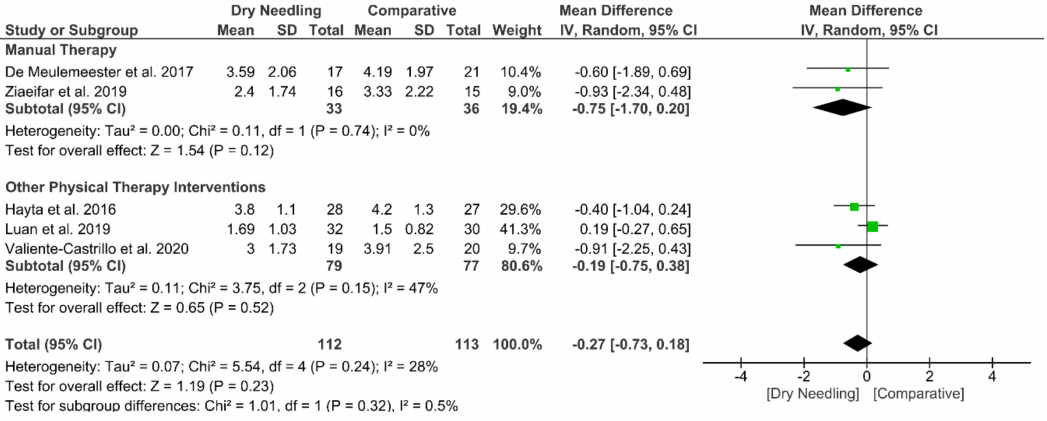
Figure 5. Mean di ff erences (MD) comparing the mid-term e ff ects of dry needling alone against sham / placebo / waiting list / other forms of dry needling or manual therapy or other physical therapy. SD: standard deviation; CI: confidence